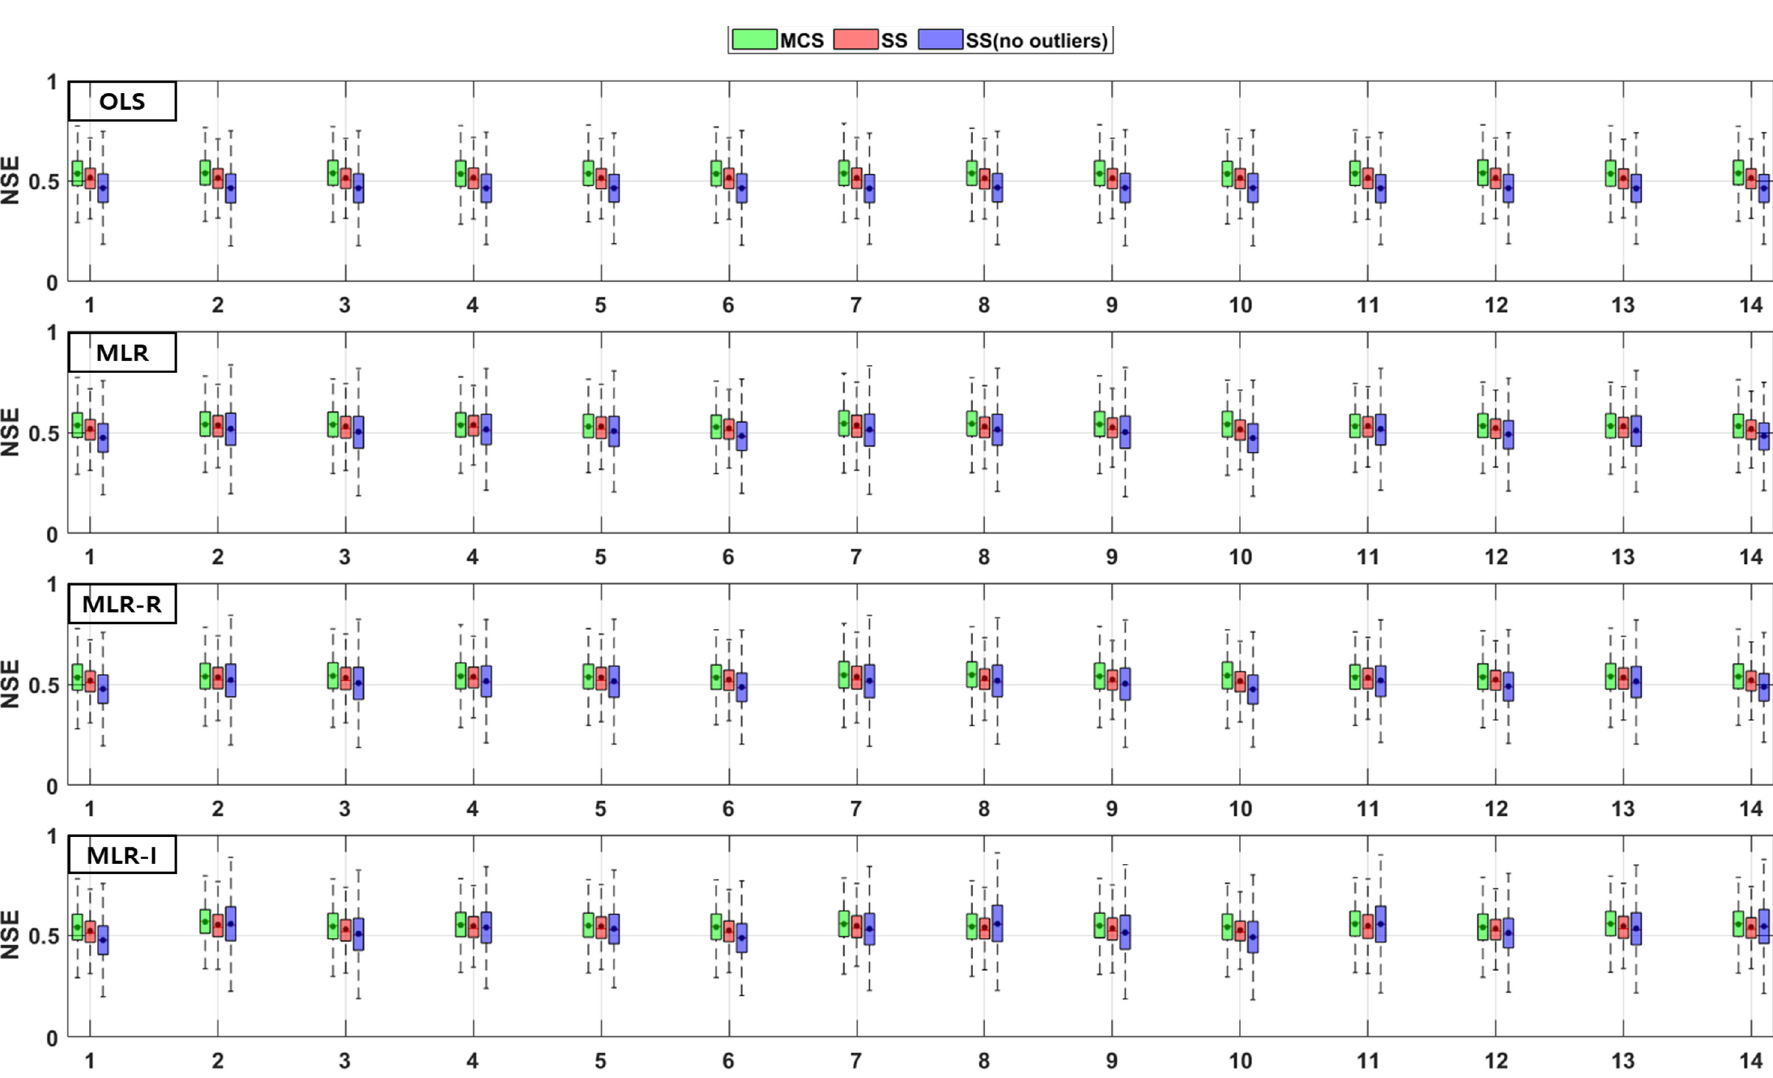
Figure 6. Error analysis (NSE) results of TSS removal in detention basins.